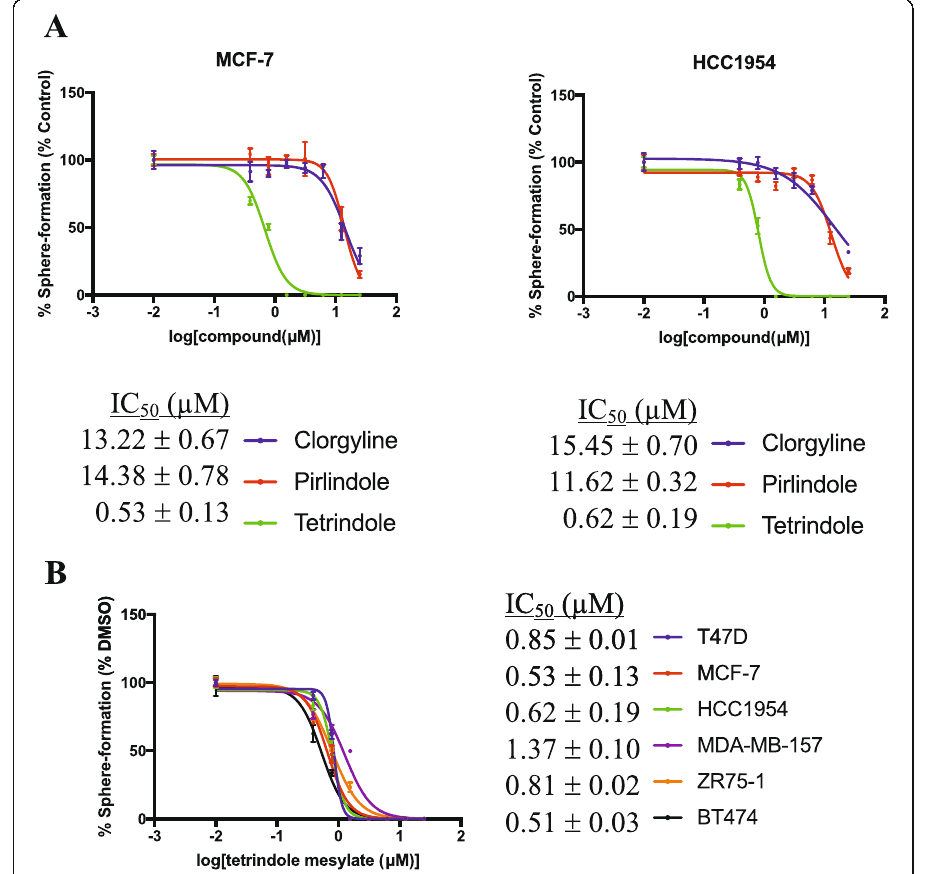
Fig. 2 Pharmacological inhibition of MAO-A activity reduces the frequency of tumorsphere-forming cells in human breast tumor cell lines. a IC 50 curves from sphere-forming assays with 3 selective MAO-A inhibitors in the MCF-7 and HCC1954 human breast tumor cell lines. b IC 50 curves for tetrindole using sphere forming assays with a panel of 6 human breast tumor cell lines. Data points represent the number of tumorspheres formed at each concentration, relative to the vehicle treated cells. IC 50 curves were generated using GraphPad Prism 7.0. Error bars represent standard error from three technical replicates. A value of 0.01 nM was used in IC 50 calculations as the vehicle-treated